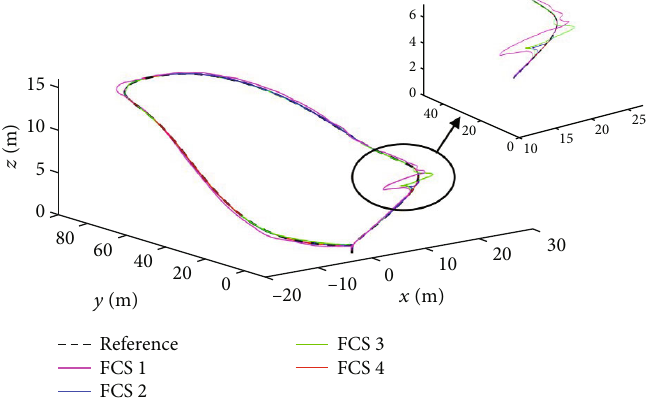
Figure 5: 3D Cartesian fl ight trajectory tracking for di ff erent fl ight control systems: fl ight scenario 1.